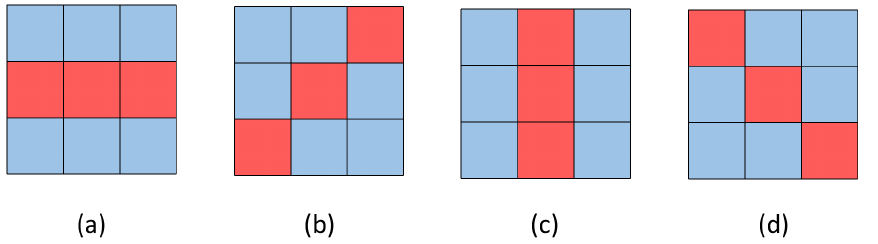
Figure 3. Weight of different pixels in the receptive field of a single neuron. ( a ) 0-degree neuron; ( b ) 45-degree neuron; ( c ) 90-degree neuron; ( d ) 135-degree